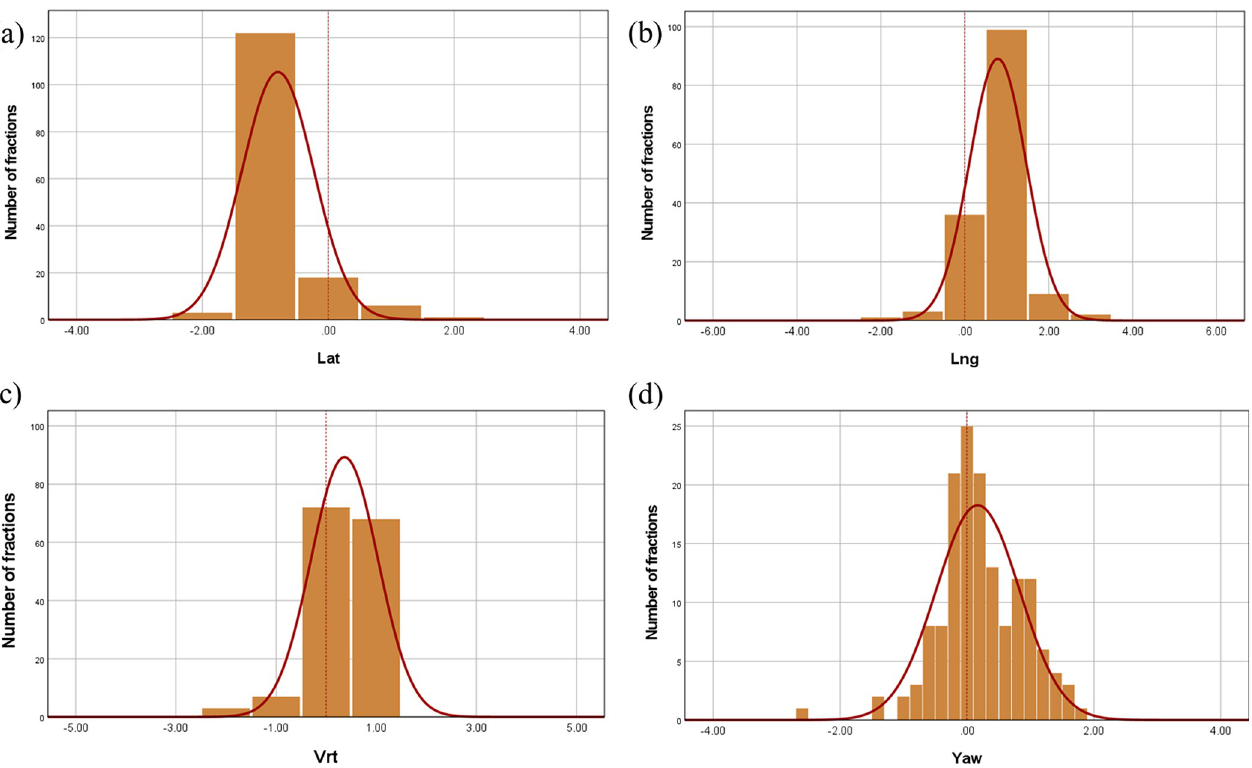
Fig 4. Histograms and normal distribution curves of the setup errors in the translation and rotation for the supine position (c-SP). Setup errors in the (A) lateral, (B) longitudinal, (C) vertical, and (D) yaw directions.